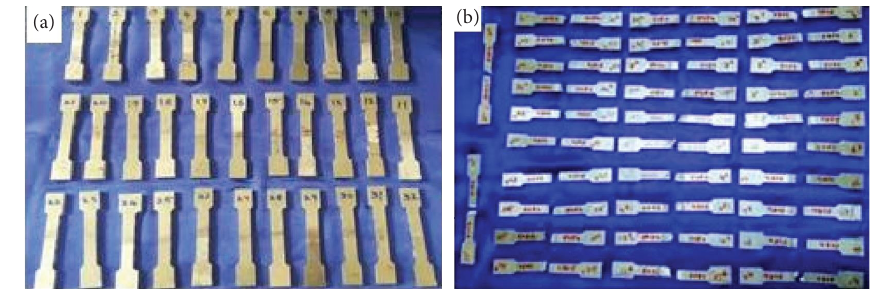
Figure 4: Tensile sample before and after testing.